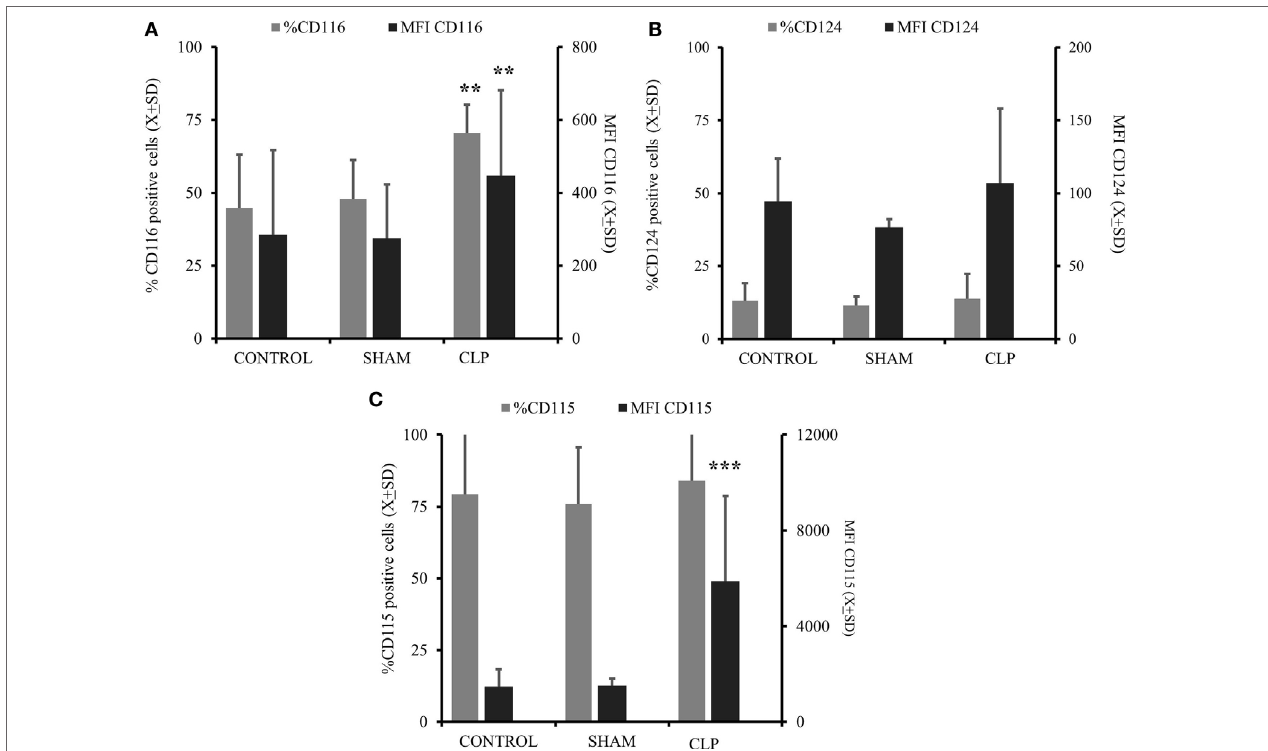
FigUre 2 | There is significant predominance of gM-csF r and M-csF r on the circulating monocytes cells post cecal ligation and puncture (clP) . Monocytes (MO) obtained from all three studied groups [CONTR n = 10, SHAM-operated (SHAM) n = 6, CLP n = 8] were incubated with specific surface antibodies against the receptors supporting differentiation of MO into dendritic cell (DC) (CD116 combined with CD124) (a,B) and receptors cytokines preventing MO to iDC differentiation like CD115 (c) or CD116 alone (a) . The flow cytometry was conducted on at least 10,000 cells using FS/SS scatters to exclude clumps and dead cells. Surface expression is present as a percent of positive cells (%) and mean fluorescent intensitiy (MFI) on the gates cells. Bars represent average of results ( X ) with SD. Data were analyzed by one-way ANOVA for multiple group comparisons with a Bonferroni test for post hoc analysis (* p < 0.05, ** p < 0.01, *** p <